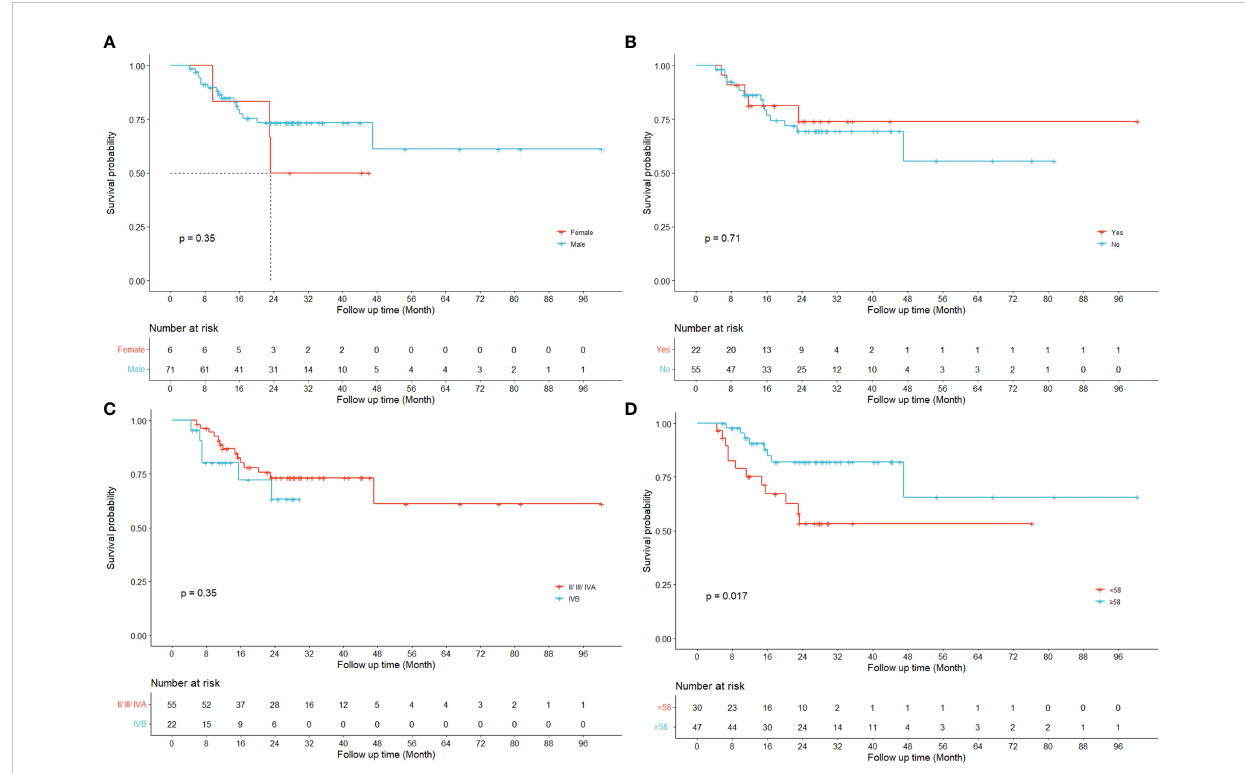
FIGURE 3 Kaplan-Meier curves for LRRFS. Univariate results are shown for four different clinical variables respectively ( (A) gender; (B) peripheral invasion; (C) total stage IVB; (D)